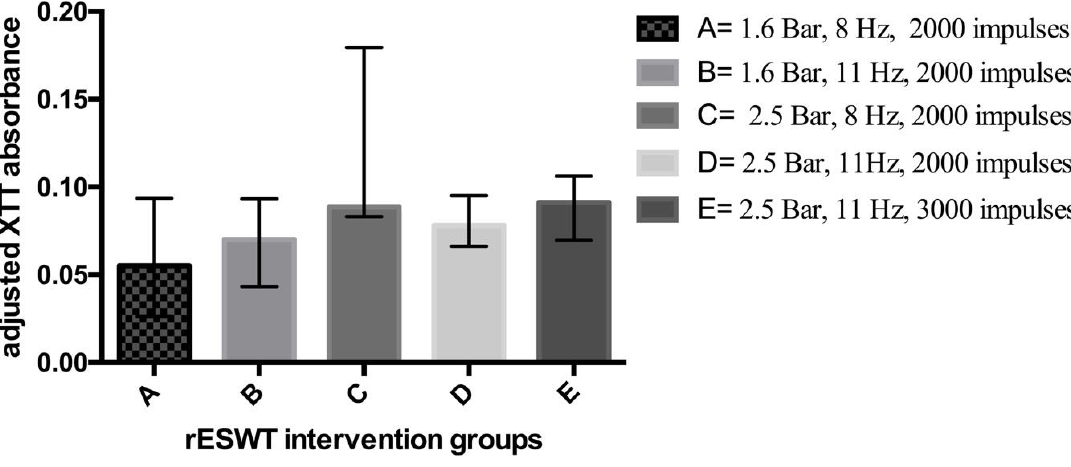
E ff ects of radial shock waves on C. acnes biofilms as measured by adjusted Figure 3. Effects of radial shock waves on C. acnes biofilms as measured by adjusted median median absorbance. rESWT = radial extracorporeal shock wave therapy; XTT = 2,3-bis(2-methoxy-4-nitro-5- sulfophenyl)-2H-tetrazolium-5-carboxanilide .